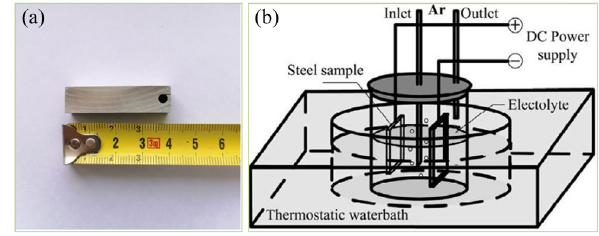
Figure 2: Schematic diagramofthe experimentaldevice forelectrolytic inclusions: ( a ) steel samples for electrolysis; ( b ) electrolytic device.